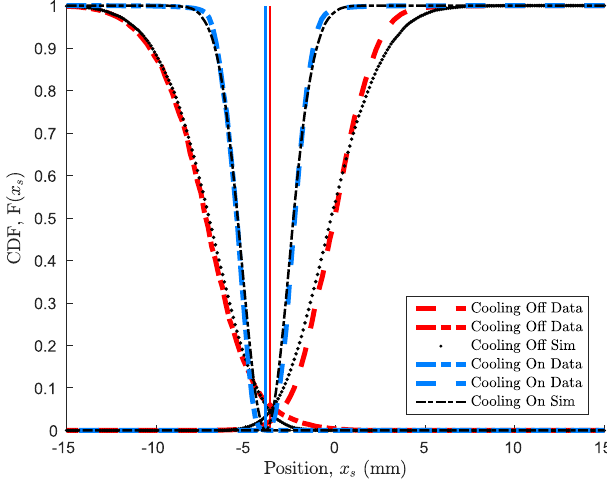
FIG. 8. CDFs extracted from horizontal scraper measurements at the 100 keV cooling plateau. Simulations of CDFs corre- sponding to Gaussian beams with the measured emittances and momentum spreads are also